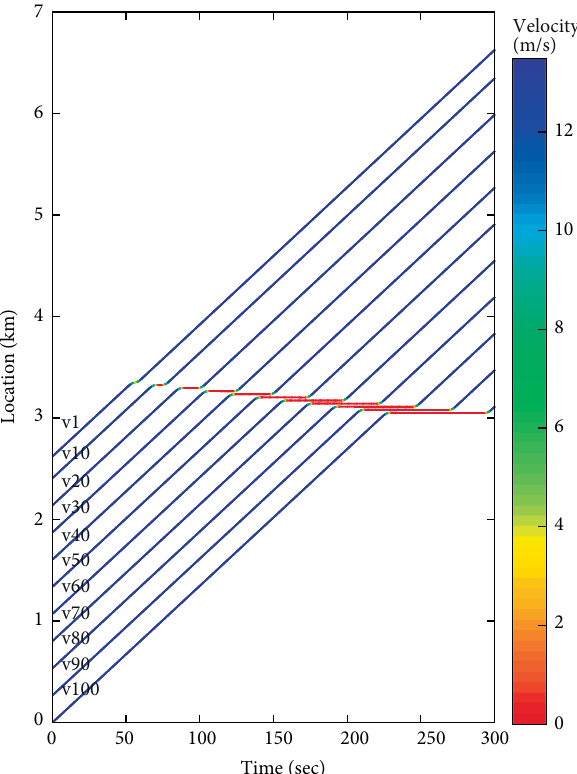
Figure 1: Time-space trajectories of 11 samples of